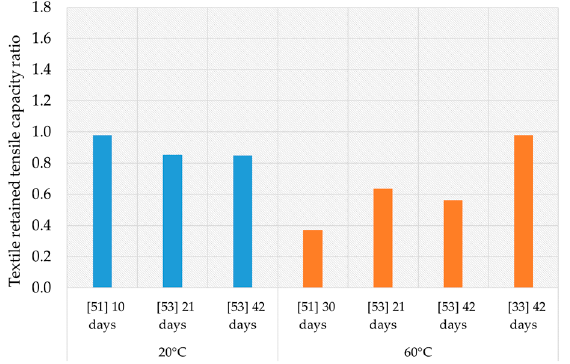
Figure 5. Retained tensile capacity ratio of AR-glass exposed to hygrothermal environments (blue bin = room temperature and orange bin = temperature equal to 60 °C).